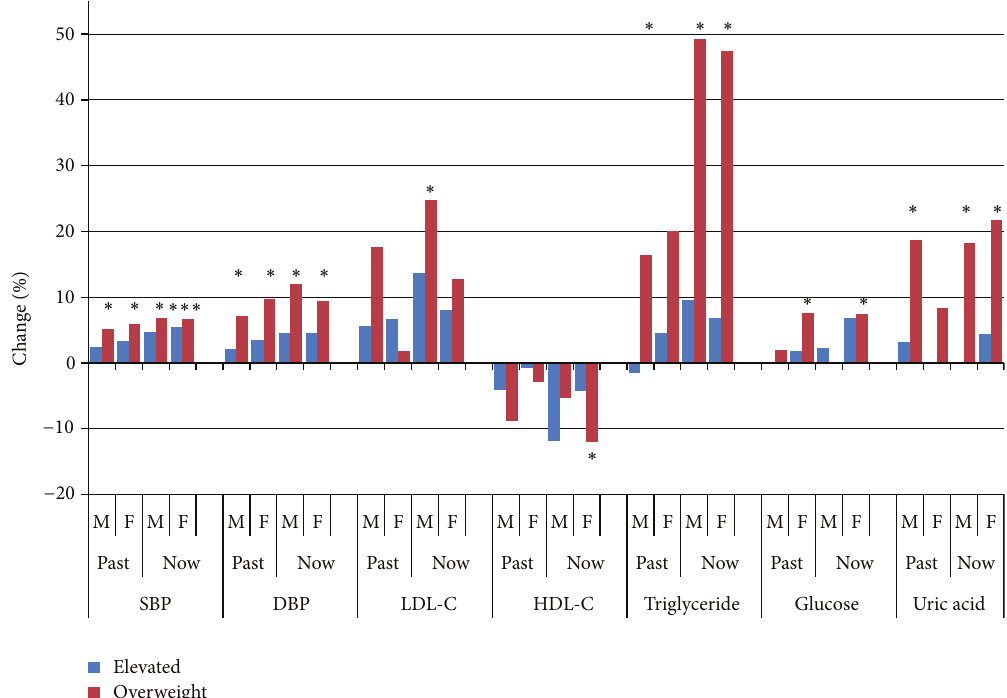
Figure1:Relativedifference(inpercent)inthemeanlevelsofcardiometabolicriskfactorsattheageof19-20yearsaccordingtoBMIcategories measured at the age of 12–15 years (past) or at the age of 19-20 years (now). The reference BMI category (“low”) includes children whose BMI is below the age- and sex-specific median; “overweight” (which also includes obesity) is defined according to standard guidelines and “elevated” BMI refers to BMI values between the “low” and “overweight” categories. SBP: systolic blood pressure; DBP: diastolic blood pressure; LDL-C: LDL cholesterol; HDL-C: HDL cholesterol; M: male; F: female; past: BMI measured at the age of 12–15 years; now: BMI measured at age of 19-20 years. The stars indicate association with statistical significance of 𝑃 < 0.05